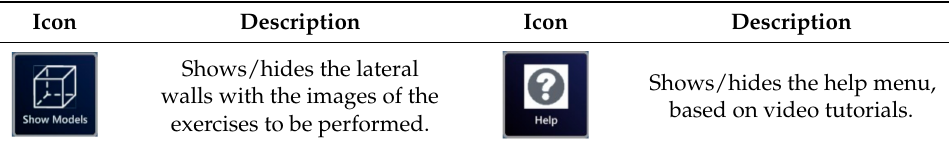
Table 1. Commands to manage tutorials and lateral walls. Icon